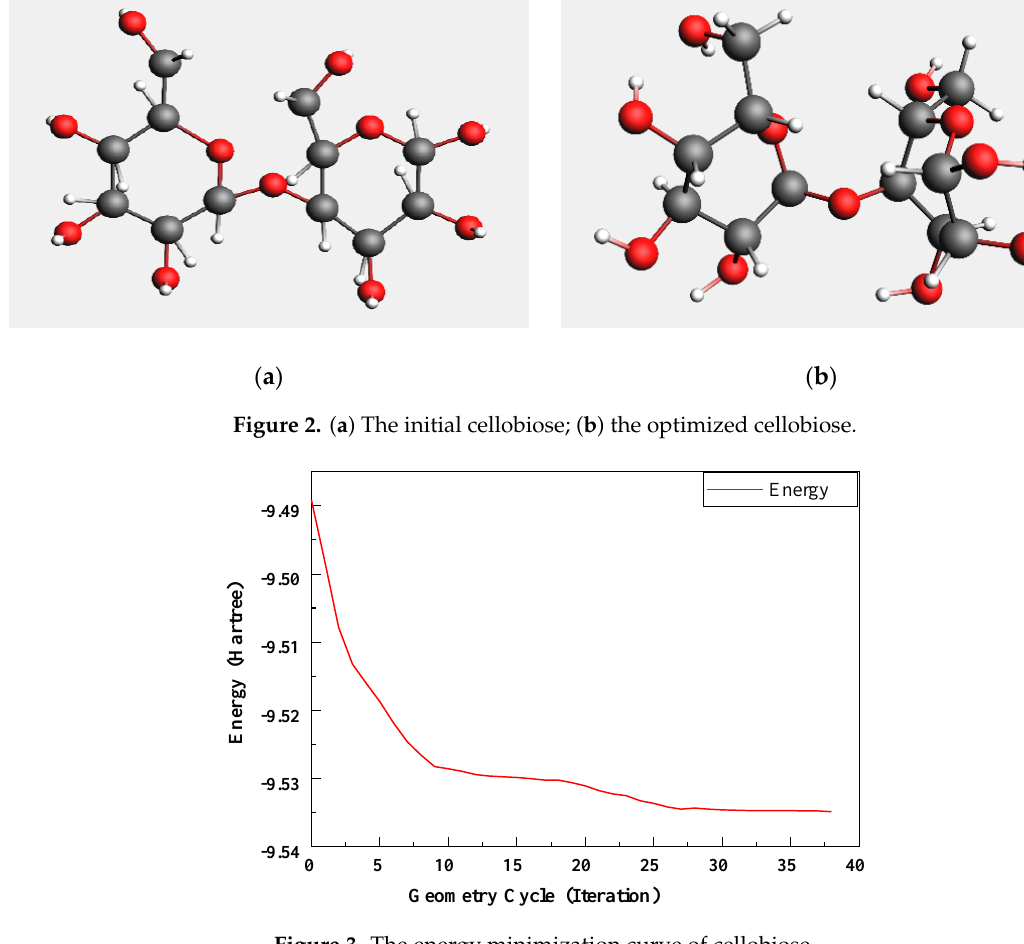
Figure 2. ( a ) The initial cellobiose; ( b ) the optimized cellobiose.